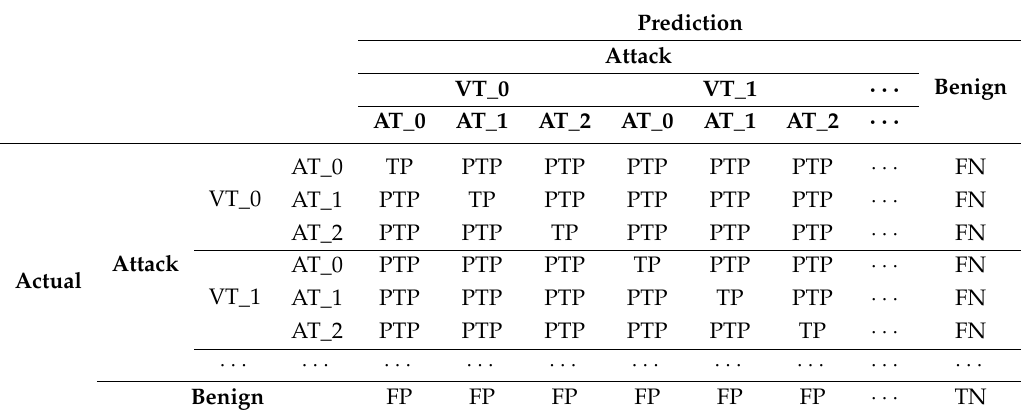
Table 4. Hierarchical confusion